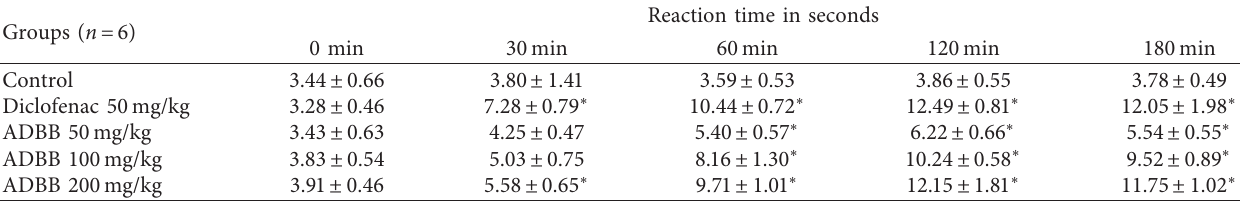
Table 3: Effect of aqueous extract of D. butyracea bark on hot plate-induced pain in rats. Groups ( n �